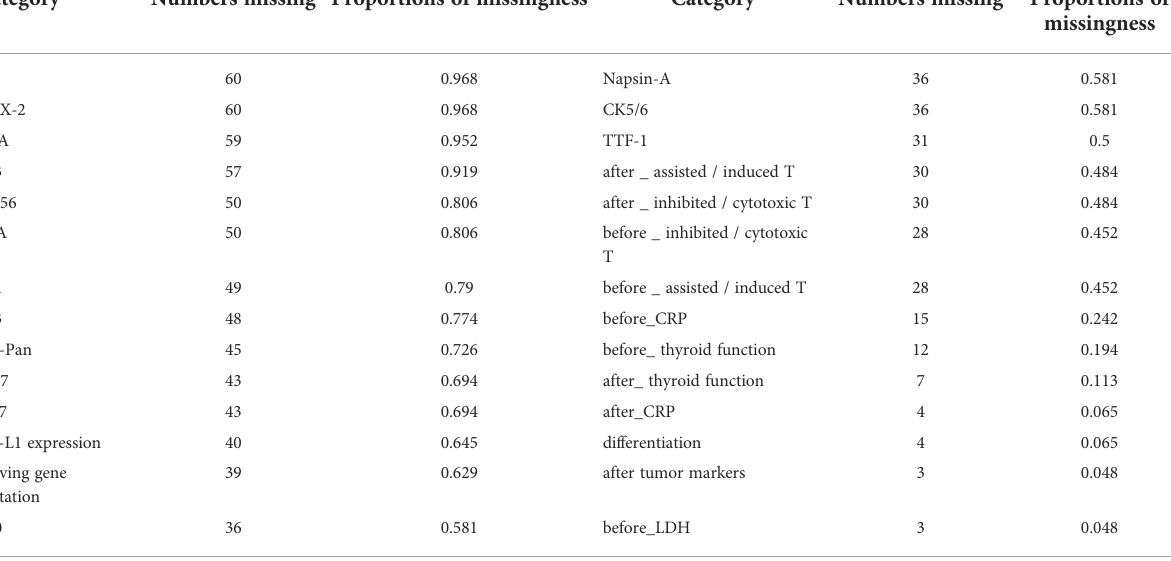
TABLE 2 Categories with missing values, numbers missing, and proportions of missingness in the clinicopathological data collected. Category